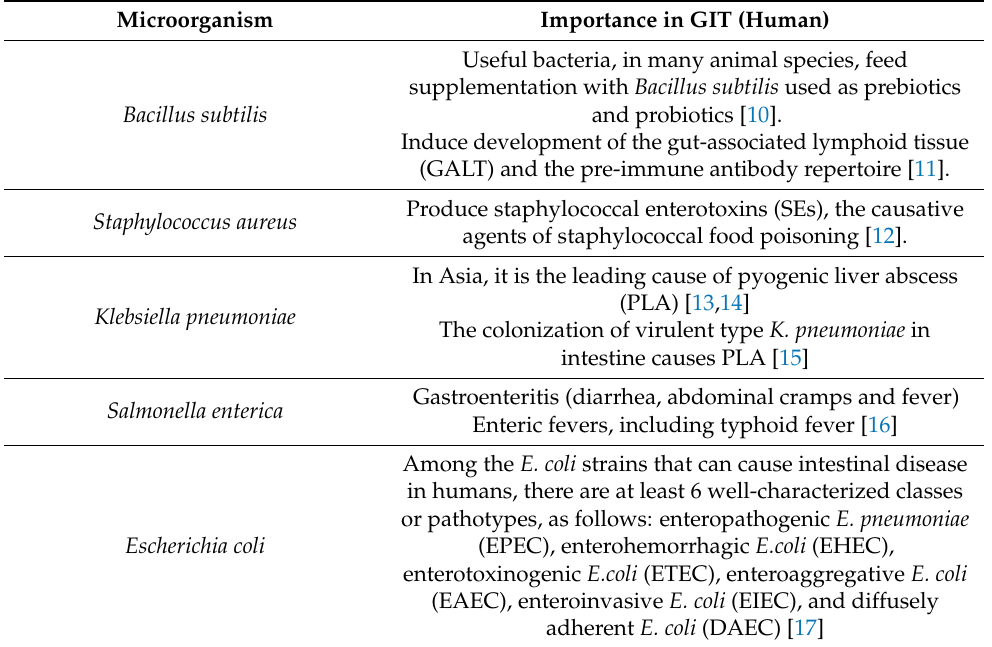
Table 1. Role of bacteria in GIT disorders in